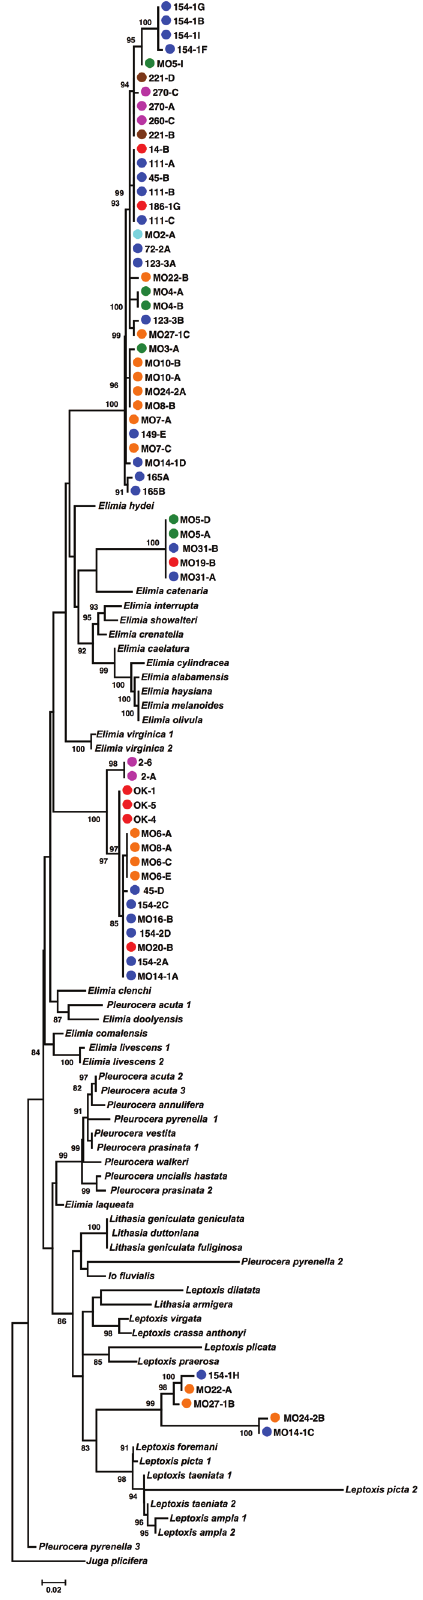
Figure 4. Maximum-likelihood phylogeny of E. potosiensis sequences. Individual snails are color-coded by river drainage and labelled according to Figure 1 and Table 1. Branches with bootstrap support ≥ 80% are